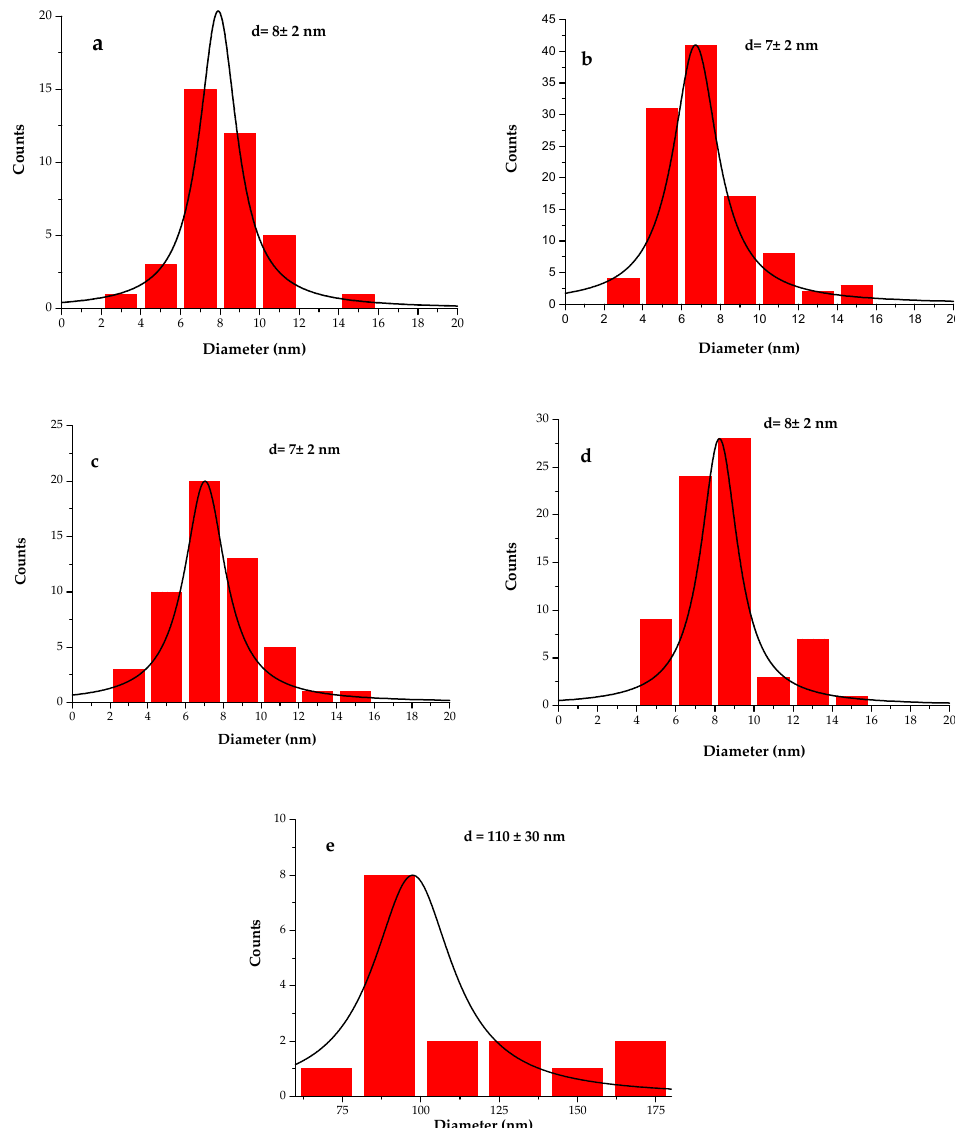
Figure 3. Particle size distributions of the selected samples ( a ) La 0.3 Zr 0.7 NiO 3 ; ( b ) La 0.3 Ce 0.7 NiO 3 ; ( c ) La 0.8 Sr 0.2 NiO 3 ; ( d ) 10 wt%Ni(0.3La 2 O 3 –0.7ZrO 2 ); ( e ) 10 wt%Ni(0.3La 2 O 3 –0.7ZrO 2.